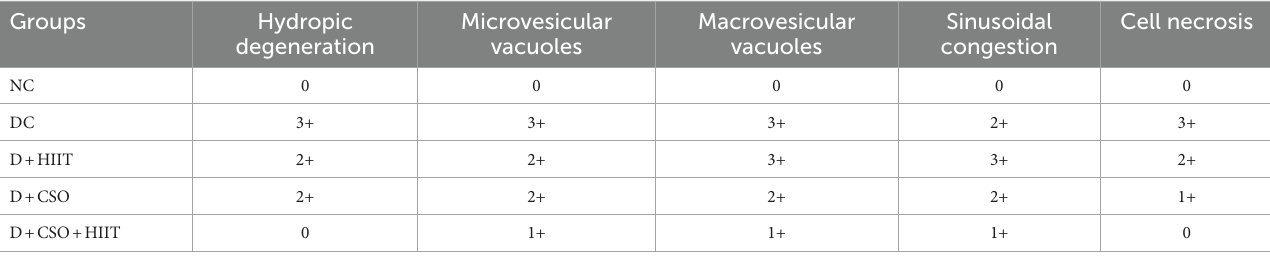
TABLE 2 The effect of camelina sativa oil and HIIT on changes in liver histopathology of male type 2 diabetic rats. Groups